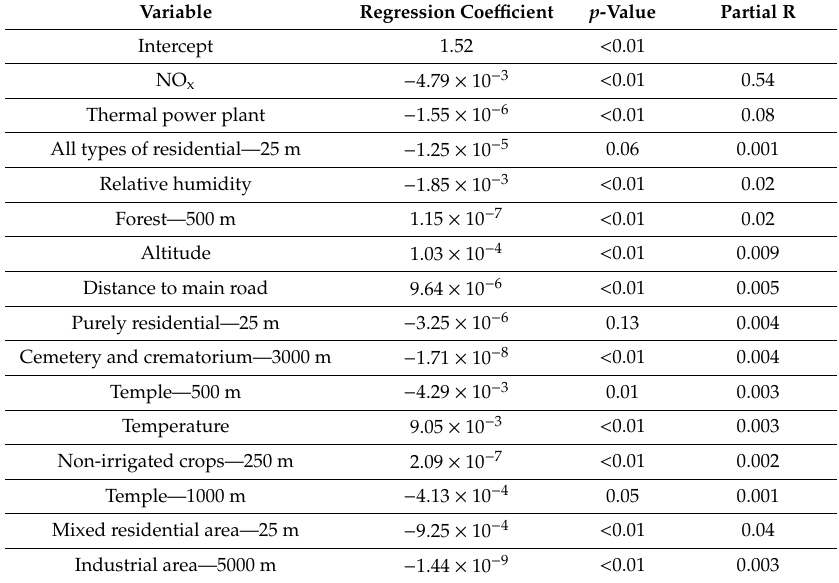
Table 2. Land use regression model for annual average ozone concentration